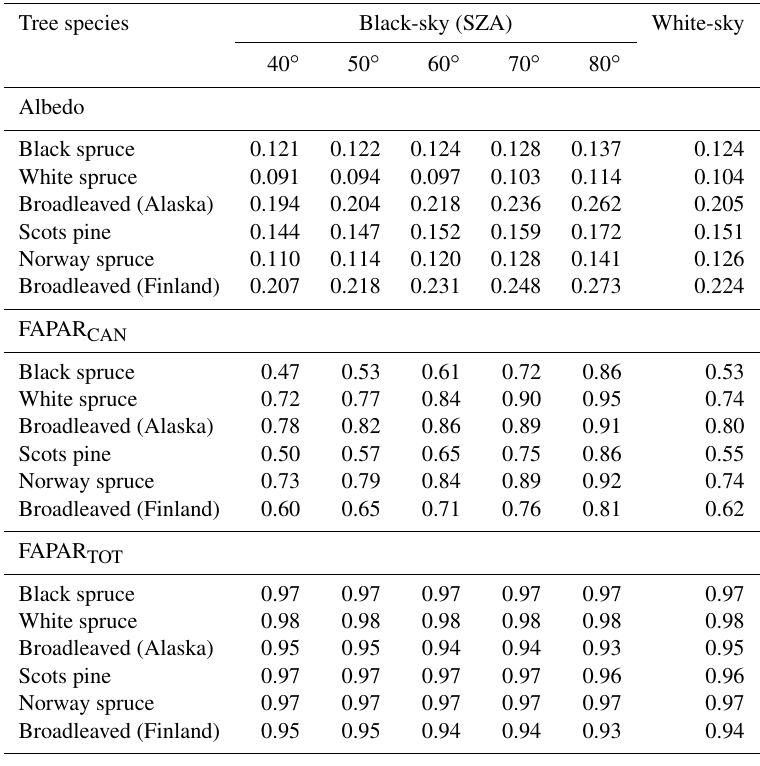
Table 4. Albedo, FAPAR CAN , and FAPAR TOT by dominant tree species and SZA. The reported value for given species is the mean of plots in which the basal area proportion of that species exceeded 80%. The number of plots and mean forest variables for each species are reported in Table